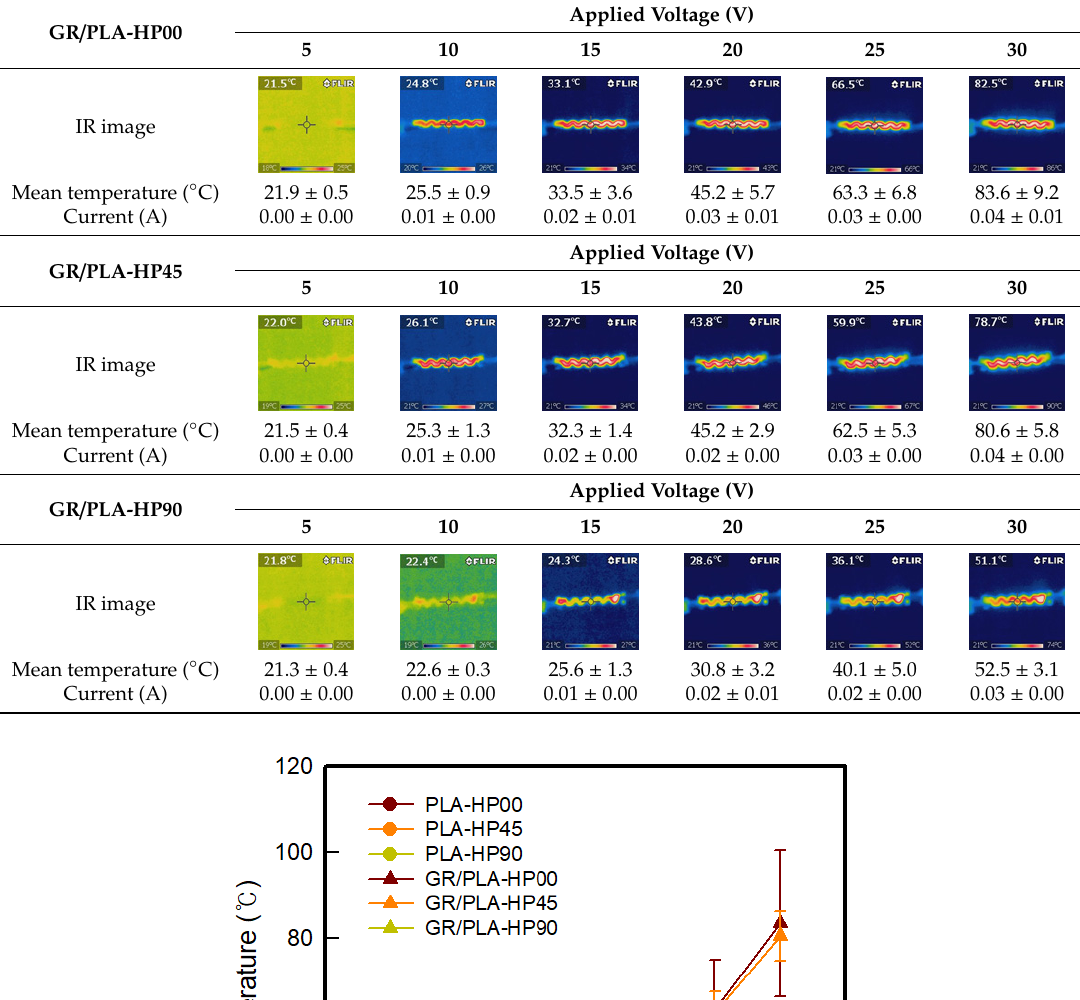
Table 7. IR images of GR/PLA CFDM 3D-printed horseshoe pattern with different 3D printing directions.